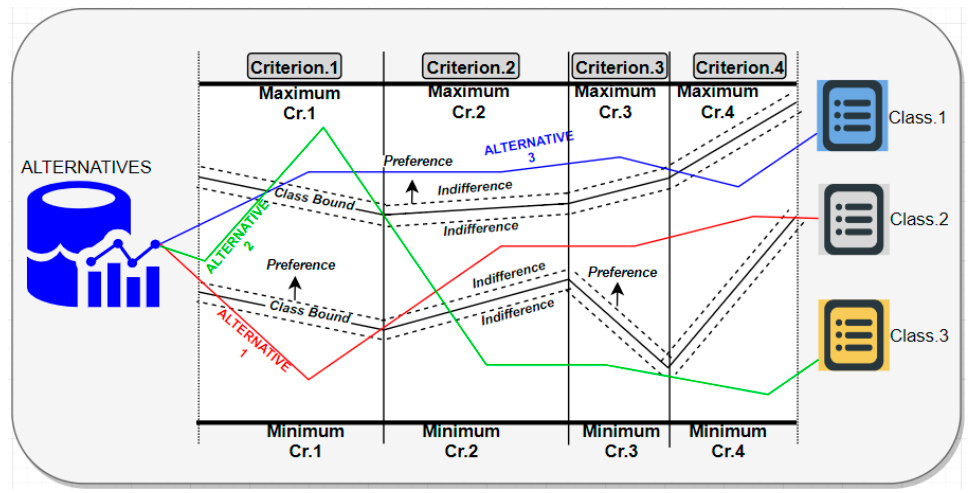
Figure 1. Sorting illustration of the ELECTRE TRI.